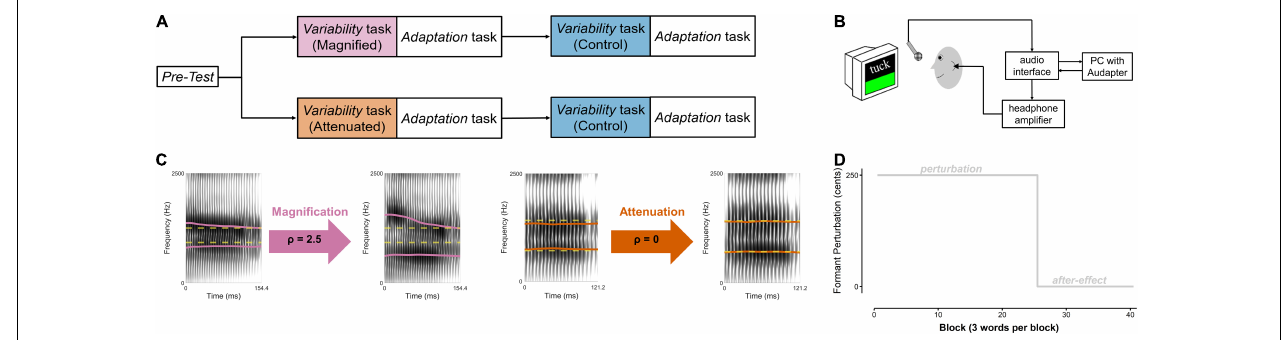
FIGURE 1 | (A) Speech tasks completed by two groups of participants. Within each group, order of the experimental condition (Magnified or Attenuated feedback variability) and the Control condition was counterbalanced across participants. (B) Instrumentation setup. (C) Example spectrograms of Difference-shifted trials in the Magnified and Attenuated conditions of the Variability task. Dashed yellow line: pre-test median formant frequencies (F1 and F2, in Hz). Solid magenta and orange lines: produced (left of arrow) and heard (right of arrow) formants in the Magnified and Attenuated conditions. (D) Time course of the formant-shift feedback perturbation in the Adaptation